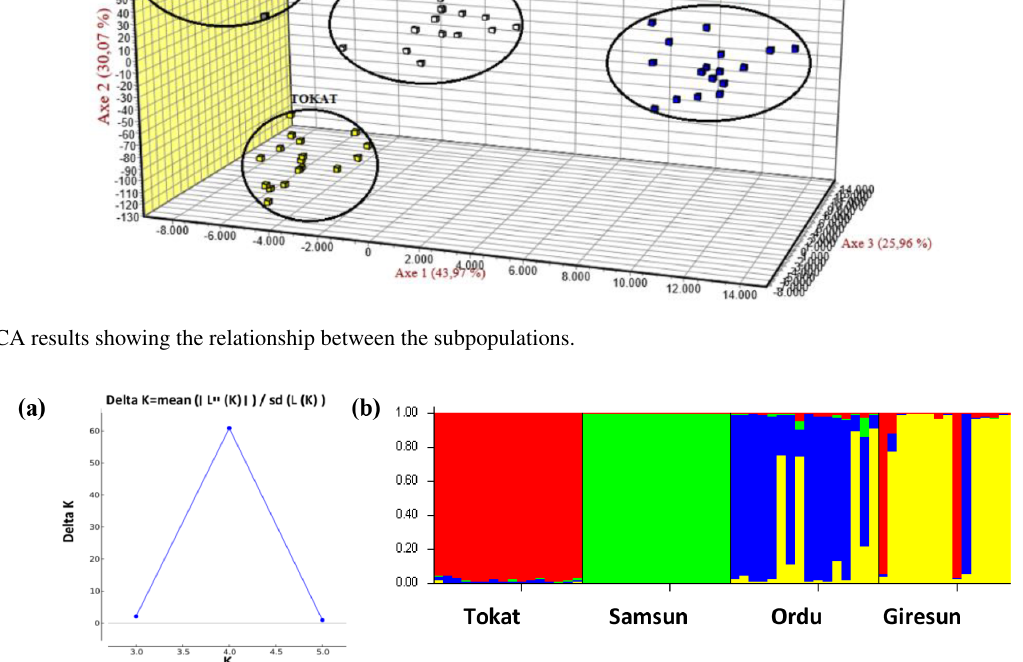
Figure 3. The results of the (cid:49)K (a) and Structure analysis (b)